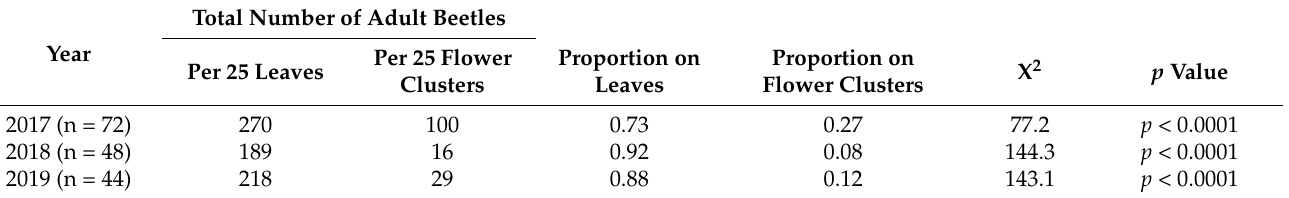
Table 4. Distribution of adult P. japonica beetles during sampling of leaves and flower clusters of ‘Heritage’ autumn-bearing raspberries, Rosemount, MN,